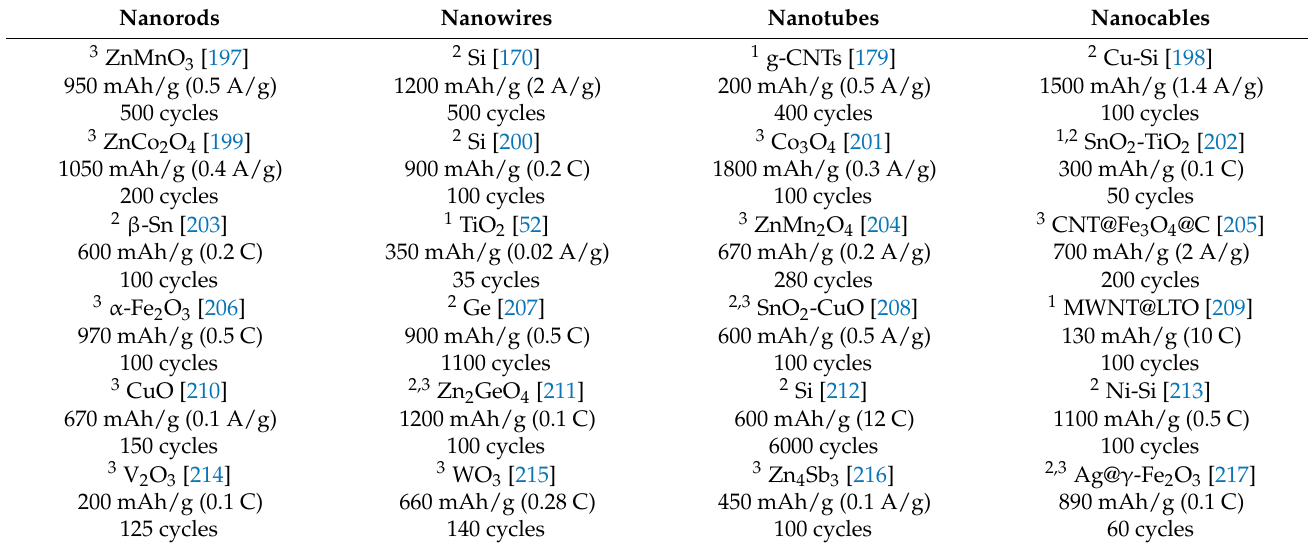
Table 1. Examples of different 1D battery nanomaterials by structure and storage